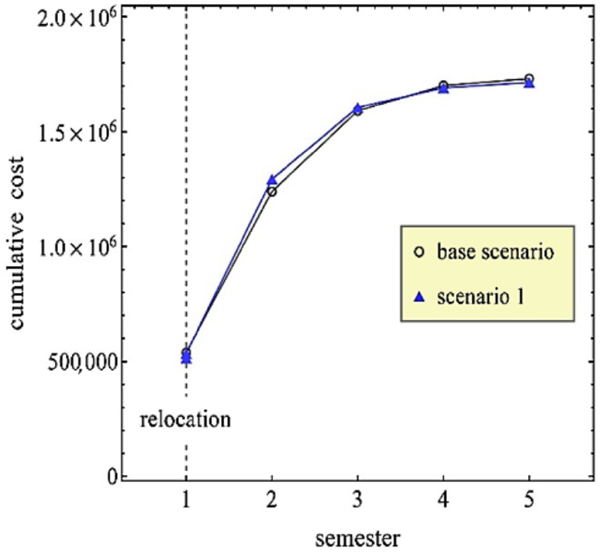
Figure 10. Comparison of cumulative costs between scenarios.